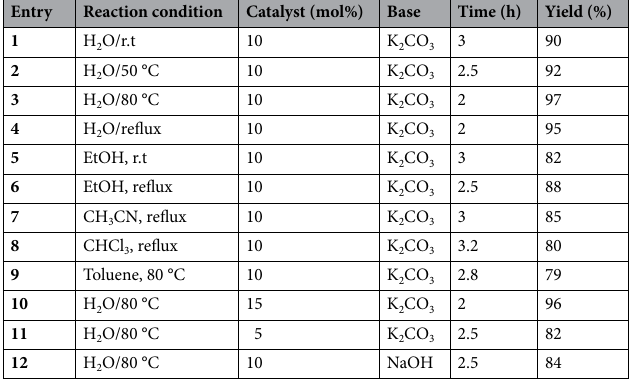
Table 1. Optimization for the coupling of aryl iodide and phenyl acetylene a . a Reaction